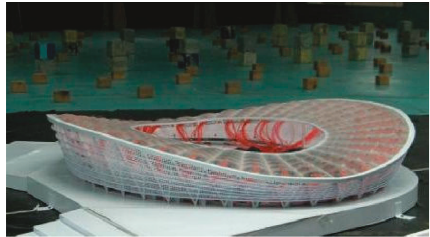
Figure 6: Rigid model of the stadium.